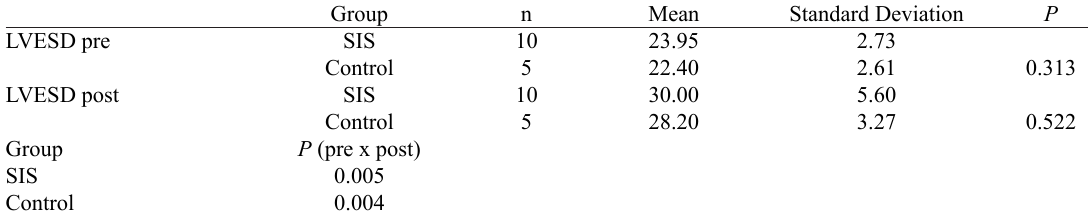
Table 3. Inter- and intra-group left ventricular end systolic diameter analysis (mm) between pre-operative evaluation and 60 days after